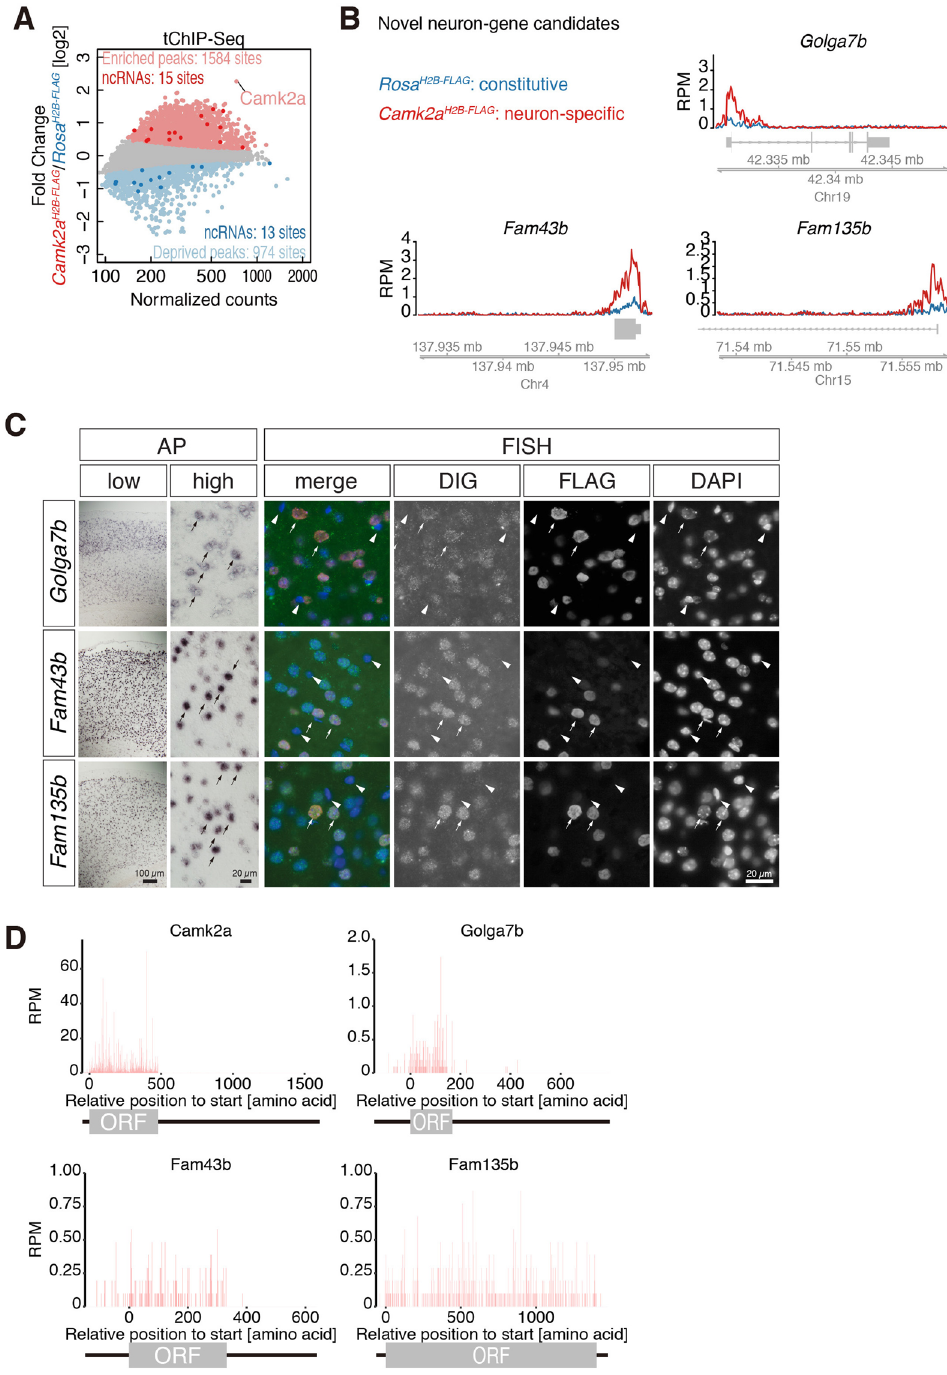
Figure 6. Novel neuron-genes identified by tChIP-Seq. ( A ) MA-plot of mean reads in H3K4me3 peaks and their differential changes in Camk2a H2B-FLAG tChIP-Seq, highlighting defined neuron-enriched and neuron- deprived loci. Significantly changed peaks (FDR < 0.01) were highlighted in light pink and light blue. Peaks assigned to ncRNAs were depicted in darker pink and blue. ( B ) Distribution of reads from tChIP-Seq of Rosa H2B-FLAG and Camk2a H2B-FLAG along novel neuron gene candidates Golga7b, Fam43b, and Fam135b. RPM: reads per million. ( C ) Expression pattern of Golga7b, Fam43b, and Fam135b in the cortex of Camk2a H2B-FLAG revealed by in situ hybridization. The transcripts were detected using chromogenic reaction of alkaline phosphatase-conjugated secondary antibodies (AP). For simultaneous detection with H2B-FLAG, the transcripts were detected with fluorescent-conjugated secondary antibodies (FISH). Distinct signals were observed in the cortical neurons identified by large, round nuclei (arrows), whereas little or no signals were observed in glial cells with small nuclei (arrowheads). Note that all the H2B-FLAG-positive cells expressed the candidate transcripts. ( D ) Ribosome footprint distribution along the novel neuronal genes. Reads assigned on each codon were